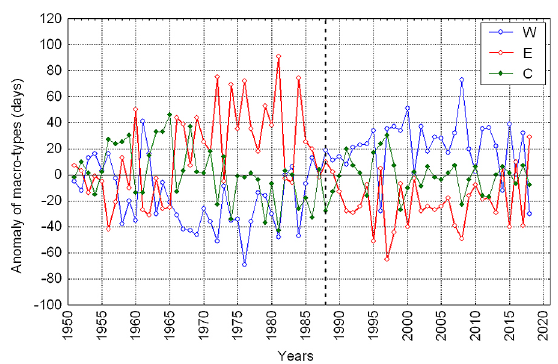
Fig. 10. The course of the anomaly of the annual frequency of W, E and C macro-types of the middle- tropospheric circulation according to the classification by Wangengejm-Girs. The anomalies are calculated with reference to averages from the period 1951– 2015. The vertical dashed line marks the moment of transition of circulation epoch E to circulation epoch